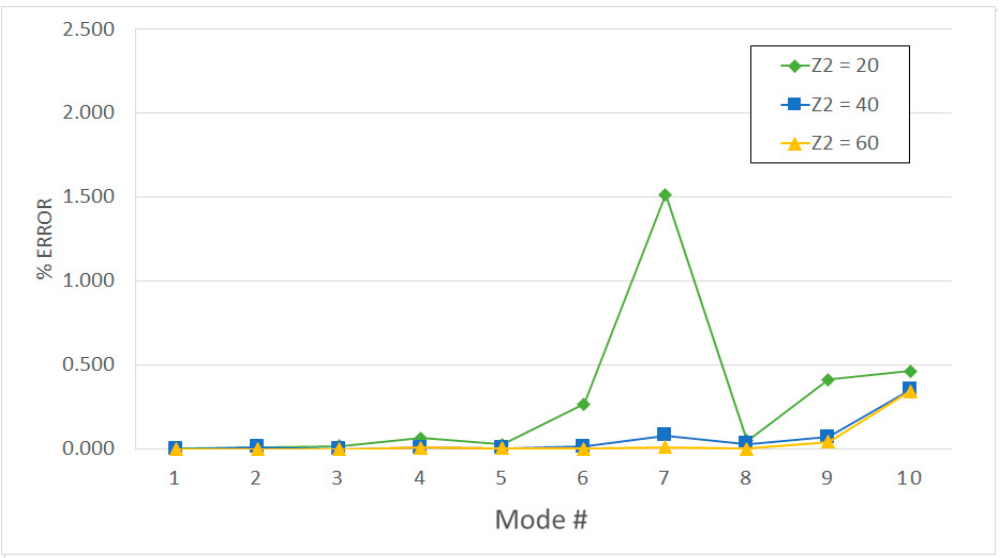
Figure 5. Test Case A (linear elements, Z 1 = 60, h = 1)—accuracy of the two-step method.